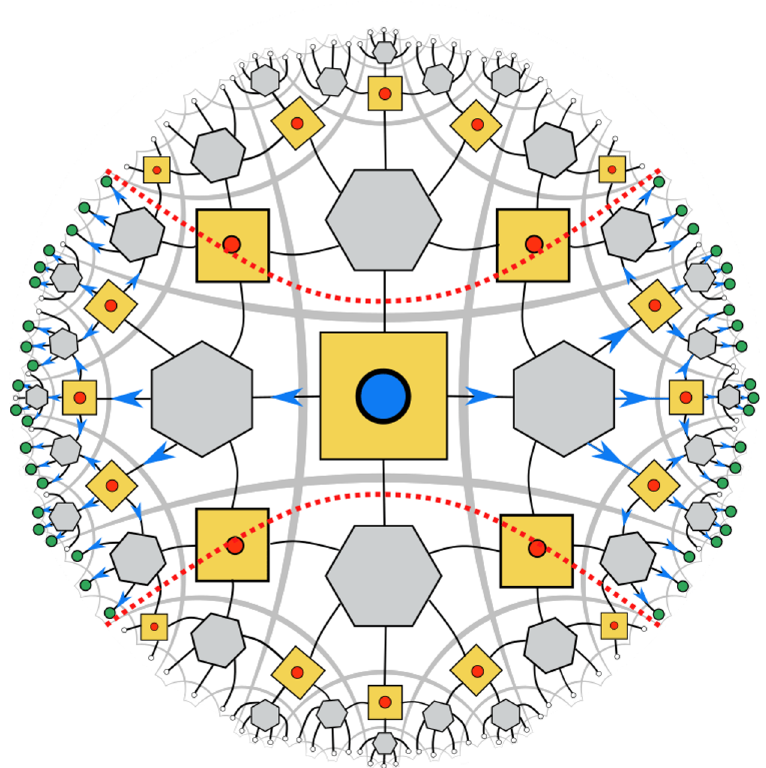
Figure 21. Central bulk operator has support on 2 legs. The operator can be supported on two disjoint intervals on the boundary, separated from its complement by the red dashed